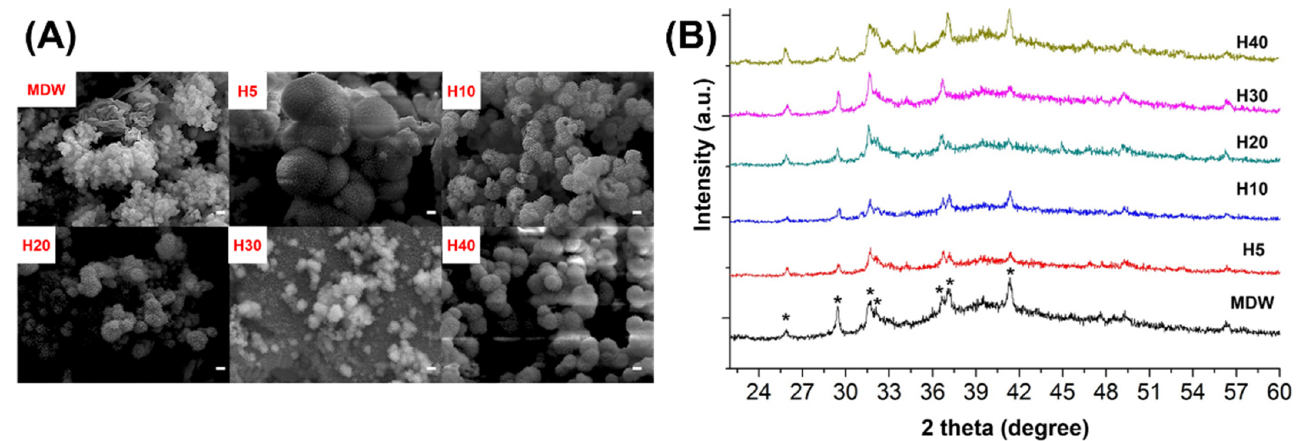
Figure 2. ( A ) Representative images of apatite formation in control and experimental groups after immersion in SBF for 28 days (scale bar = 1 μ m). ( B ) X-ray diffractograms highlighting hydroxyapatite phase.